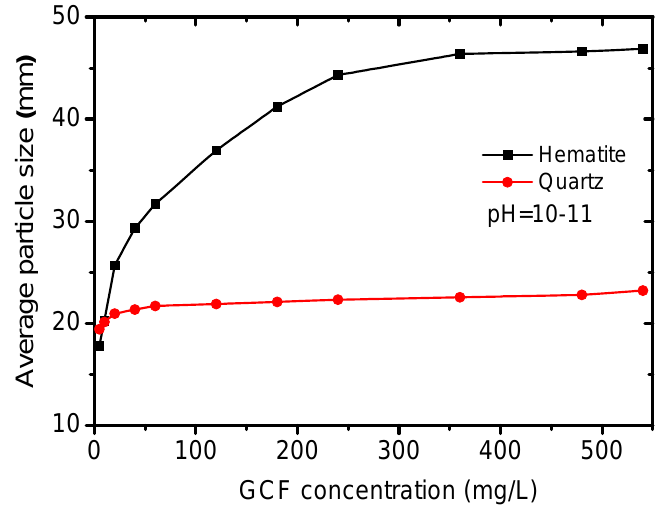
Figure 7. Effect of GCF concentration on the mean floc sizes.